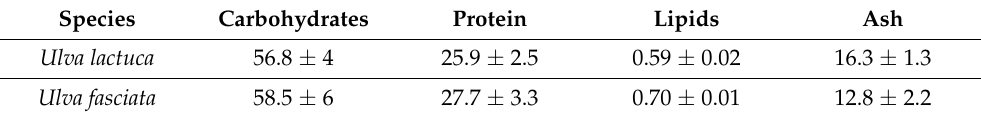
Table 1. Chemical composition as a percentage of the dry weight of Ulva lactuca and Ulva